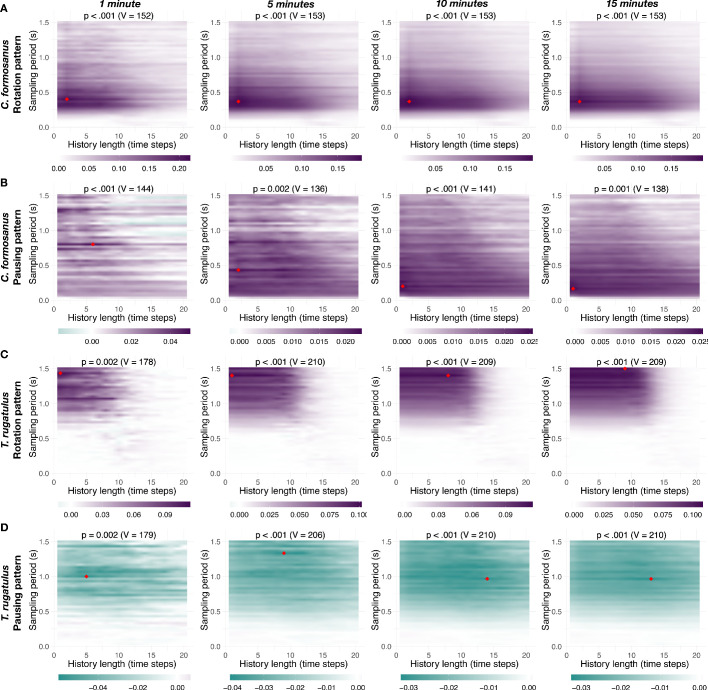
Impact of amount of data on the landscape information transfer.Net transfer entropy (bits) as a function of the sampling period and of the history length for increasing length of time series (1, 5, 10, and 15 min). (A) and (B) show the results for the rotation pattern and for the pausing pattern for C. formosanus. (C) and (D) show the results for the rotation pattern and for the pausing pattern for T. rugatulus. Colors indicate the intensity and predominant direction of information transfer (purple, from leader to follower; green, from follower to leader); the red diamond symbol indicates the configuration with maximum absolute magnitude and each panel reports the result of a one-sided paired Wilcoxon signed-rank test with continuity correction (p-value and V statistic) testing the significance of the observed effect for this parameter configuration.